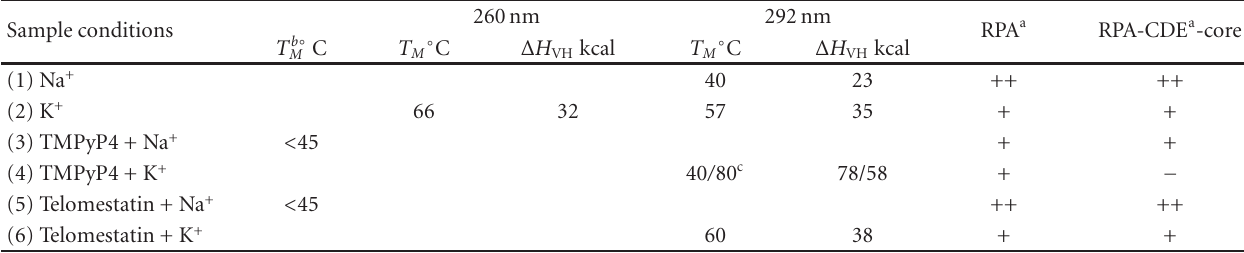
Table 1: Spectroscopic melting parameters and RPA unfolding of Gq23 in various